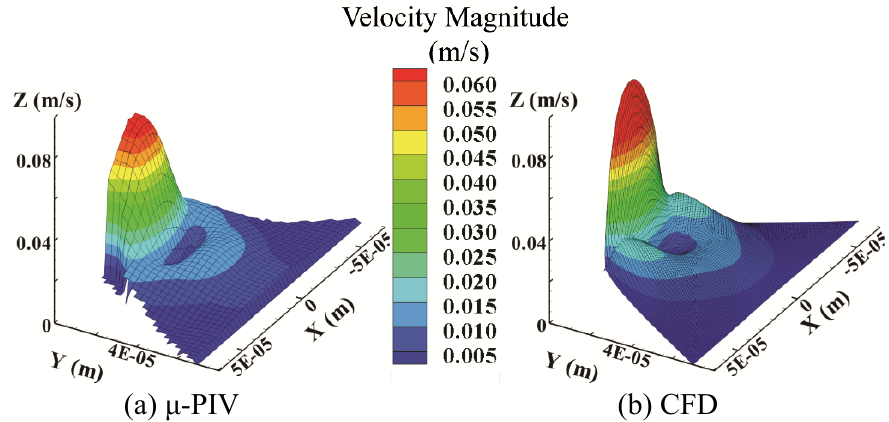
Figure 5. Comparison between µ-PIV ( a ) and CFD ( b ) surface plots of velocity magnitude versus